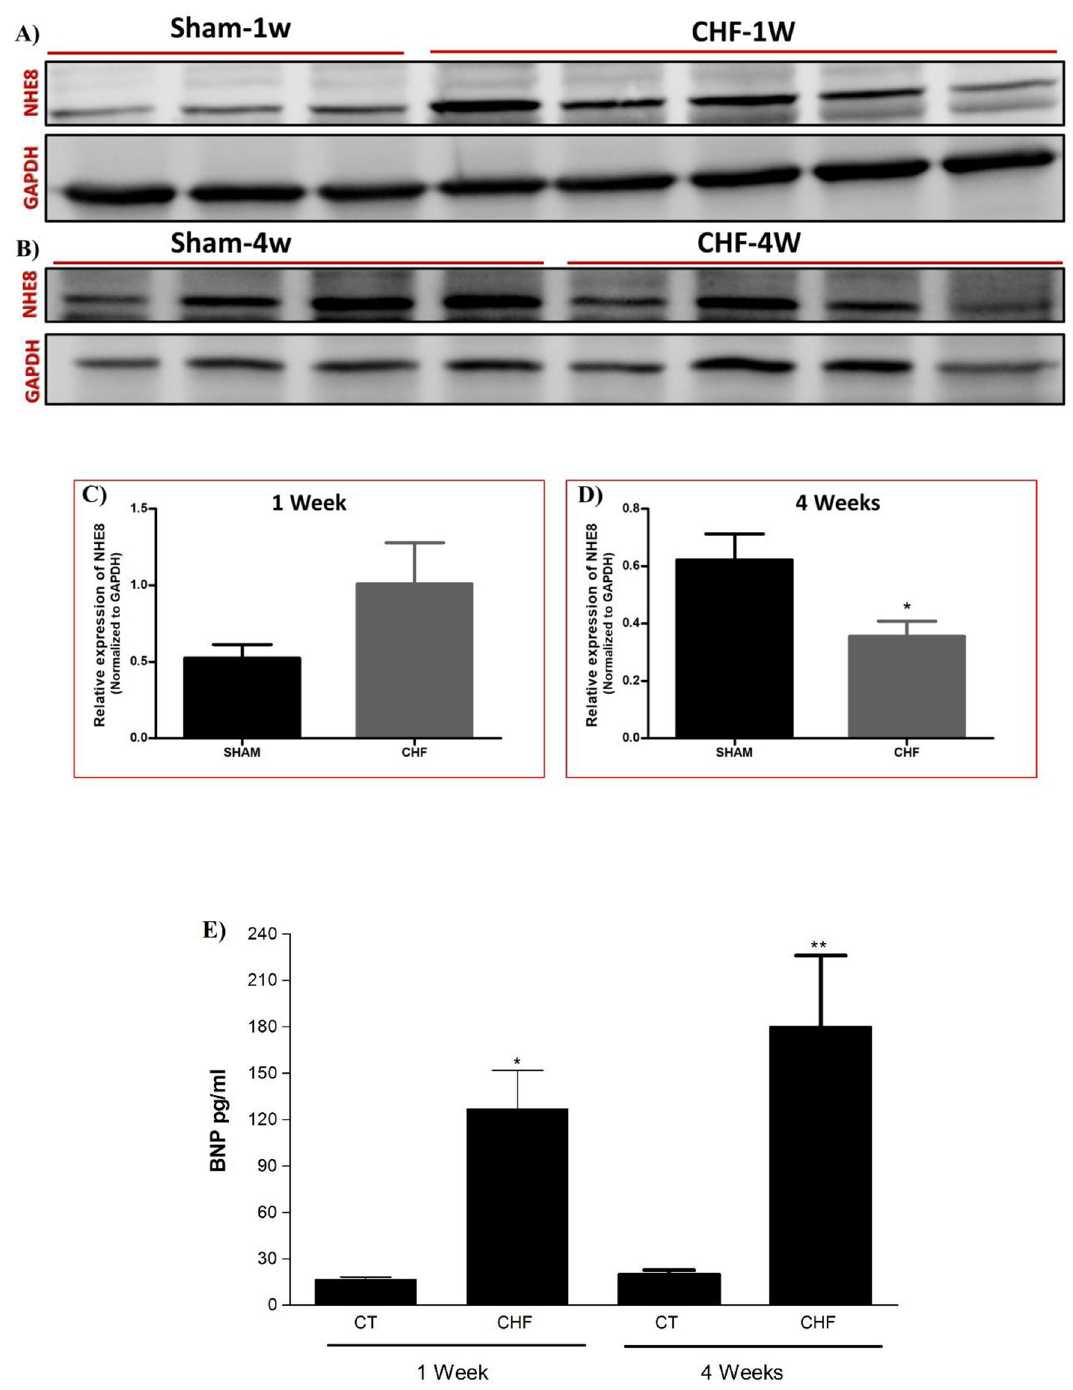
Fig 4. NHE8 immunoreactive levels in the lungs of CHF-1w and CHF-4w rats. (A) Western blot showing increased NHE8 protein levels in CHF-1w (n = 5) as compared to their Sham-1w (n = 3). (C) Quantification of NHE8; normalized to GAPDH. (B) Western blot showing decreased NHE8 protein levels in CHF-4w (n = 4) as compared to their Sham-4w (n = 4). (D) Quantification of NHE8; normalized to GAPDH. � P_Value < 0.05. (D) The severity of CHF was noted by the levels of BNP. serum BNP levels was significantly increased in the 1—week CHF group as compared to control group; � P = 0.016. Similarly in the 4 –weeks CHF group, BNP was significantly increased as compared to control; �� P < 0.01. The bars represent mean ± SEM. CHF—Congestive Heart Failure. NHE— Na+/H+ Exchanger. GAPDH—Glyceraldehyde 3- Phosphate Dehydrogenase. Serum BNP of < 100 pg/ml was considered normal.